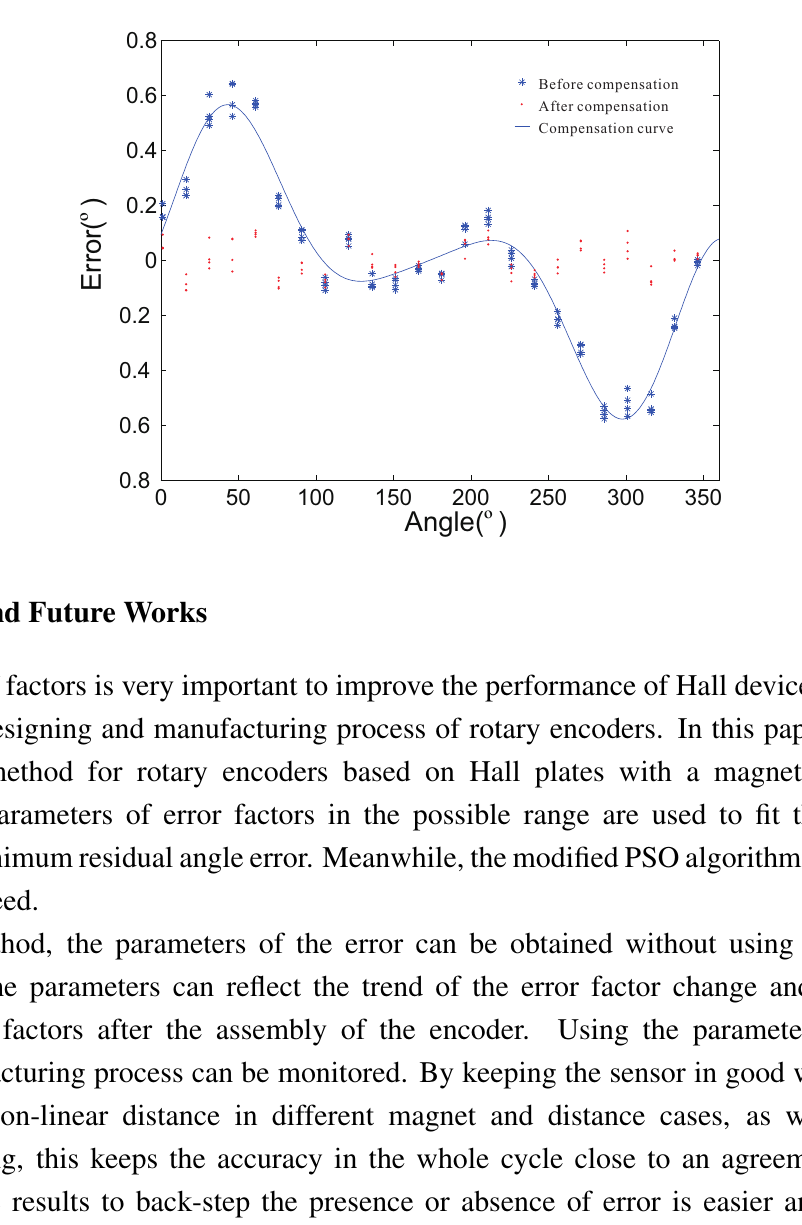
Figure 16. The error before and after the